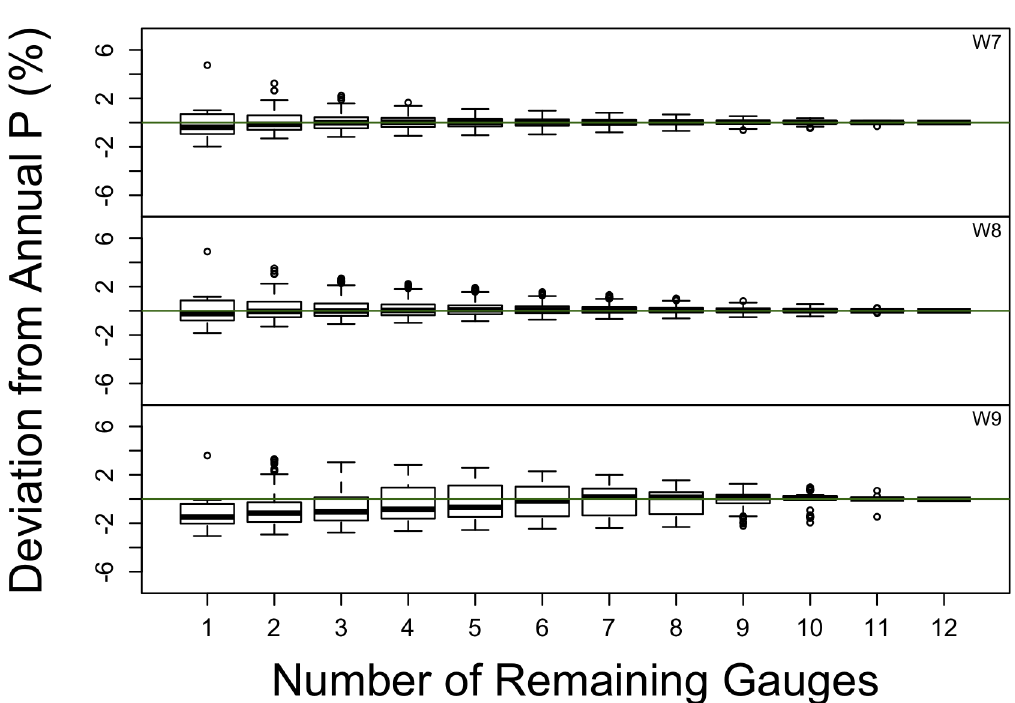
Fig 4. The effect of removing gauges for each of the three north-facing catchments is shown as the absolute value of the deviation of annual precipitation estimates for all possible combination of gauges. The results are shown as a function of the number of gauges remaining. The deviation from annual precipitation is based on the IDW method. The green line indicates zero